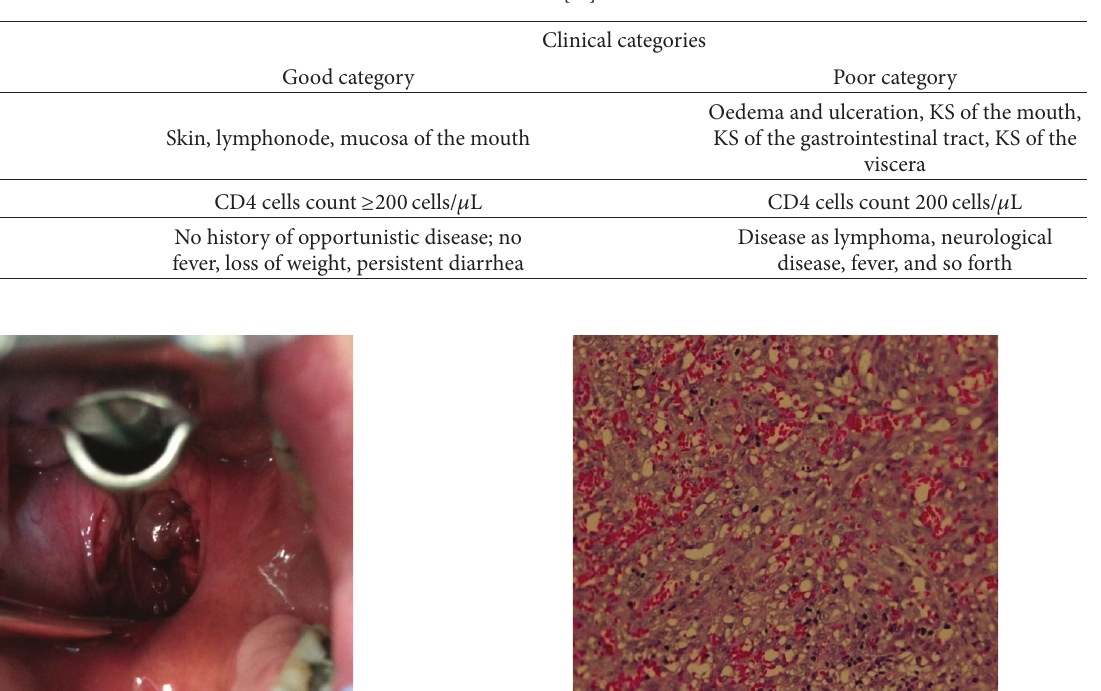
Table 1: TIS classification [17].